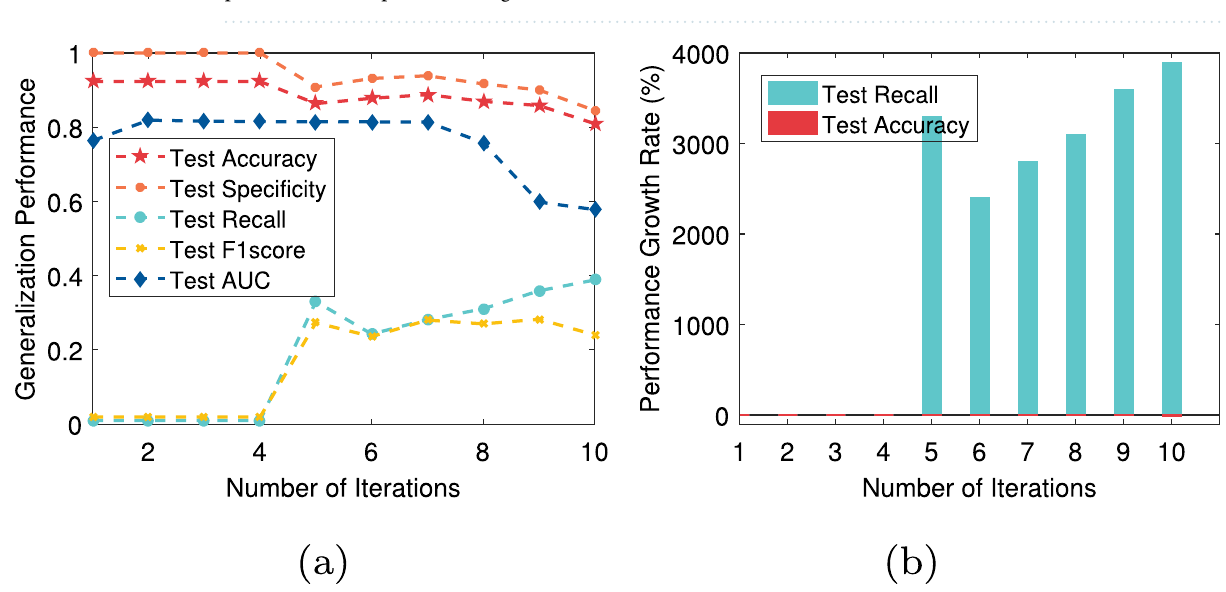
Figure 4. The test performance versus number of iteration on Fra_Heart dataset: ( a ) generalization performance; ( b ) performance growth rate.